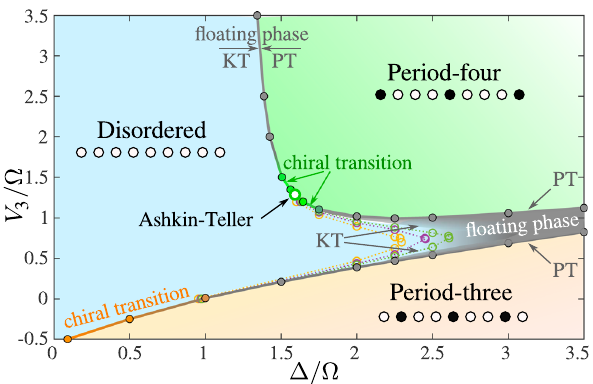
Fig. 2 Phase diagram of the hard-boson model with two-site blockade. At the commensurate transition point located at Δ / Ω ≃ 1.593 and V 3 / Ω ≃ 1.2839 the transition is in the Ashkin – Teller universality class with λ ≃ 0.57 (open green circle). Away from it but not too far (for V 3 / Ω ≲ 1.8 and for Δ / Ω ≲ 1.7), our results are consistent with a chiral transition in the Huse – Fisher 30 universality class. Further away from the Ashkin – Teller point we detect intermediate fl oating phases bounded by Pokrovsky – Talapov (PT) and Kosterlitz – Thouless (KT) transitions. Above the Ashkin – Teller point the width of the fl oating phase is always smaller than the width of the gray line. The transition into the p = 3 phase is a direct chiral transition from the disordered phase at small Δ / Ω and a PT transition from the fl oating phase at large Δ / Ω 26 . For large Δ / Ω , the two fl oating phases adjacent to the p = 3 and p = 4 phases eventually merge into a single fl oating phase connecting the two ordered phases. Dotted lines are constant correlation length lines with ξ = 50 (yellow), 100 (purple), and 200